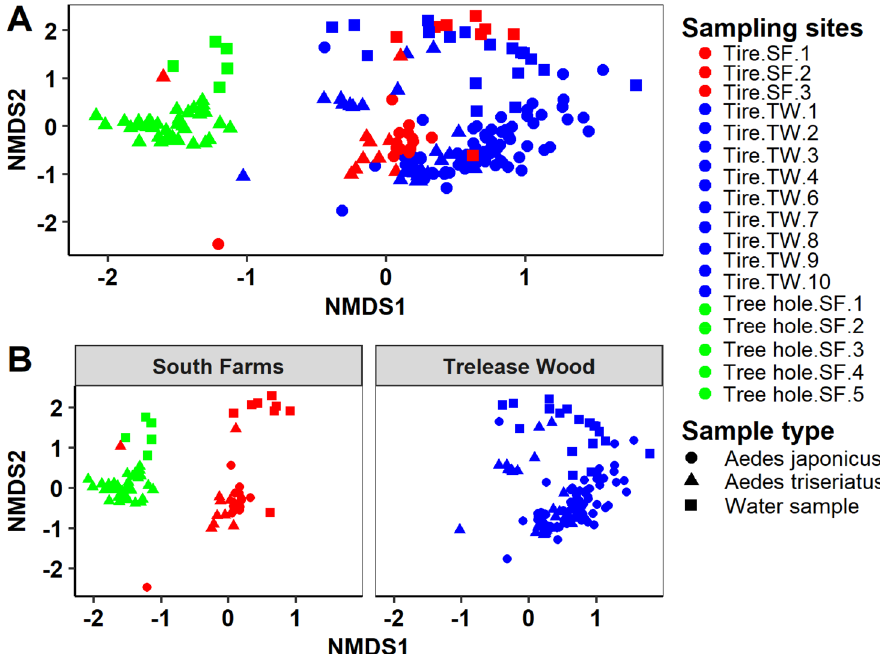
Figure 4. NMDS using Bray–Curtis distance matrix comparing bacterial communities between Aedes japonicus, Aedes triseriatus and water samples by individual sampling sites. ( A ) Combined plot; ( B ) bacterial OTU data partitioned by habitat type. SF South Farms, TW Trelease Woods.